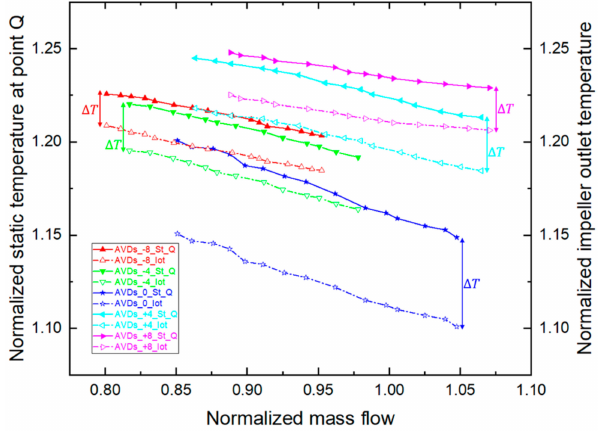
Figure 10. Characteristic curves of static temperature at point Q of IBC and impeller outlet tempera- ture under variable AVDs’ angles.